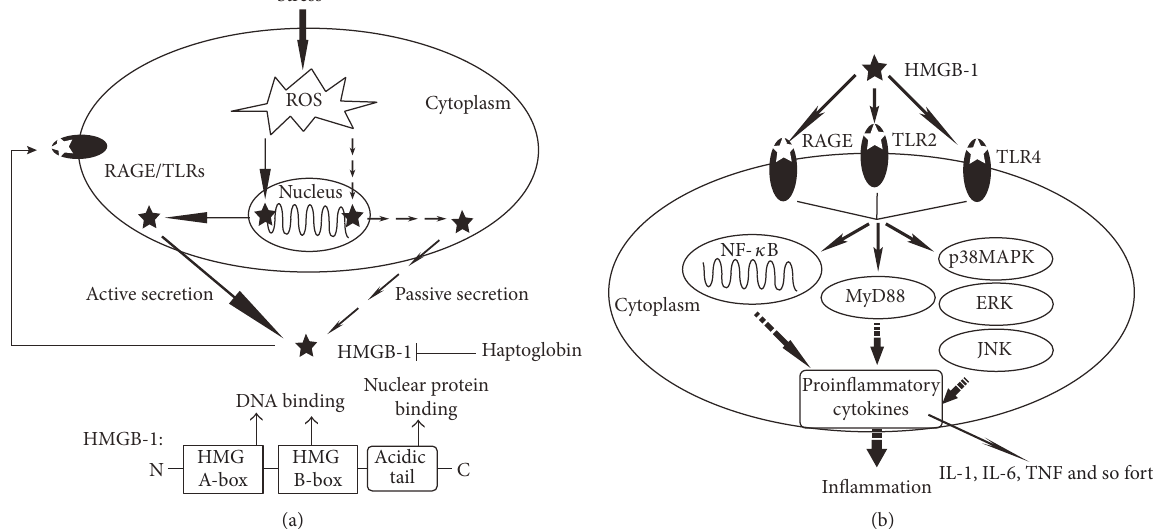
Figure 1: Schema depicting the structure of HMGB-1 and the molecular mechanisms responsible for the role of HMGB-1 in inflammation. (a) HMGB-1 translocates from the nucleus to the cytoplasm under oxidative stress condition and then is actively (immune or active inflammatory cells) or passively (death, apoptosis, or necrosis cells) released outside the cells. Once it is released into the extracellular space, HMGB-1 in turn promotes oxidative stress by binding to its receptors (such as RAGE, TLR2, and TLR4). (b) Extracellular HMGB-1 binds to its receptors and induces inflammatory response via various signaling pathways involving NF- 𝜅 B, MyD88, p38MAPK, ERK, and JNK.